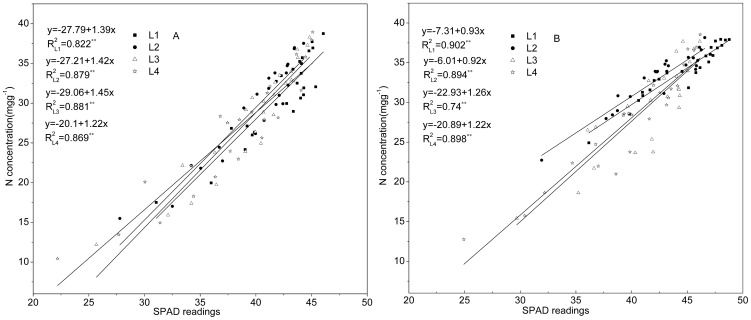
Linear regression relationship between SPAD readings and Na in the canopy leaves after DAT 62 in (A) 2008 and DAT 60 in (B) 2009.L1, L2, L3 and L4 represent the first, second, third and fourth fully expanded leaf from the top of plant, respectively. Lpool represent pooled datum of L1 - L4 SPAD readings. Solid lines represent linear regressions.